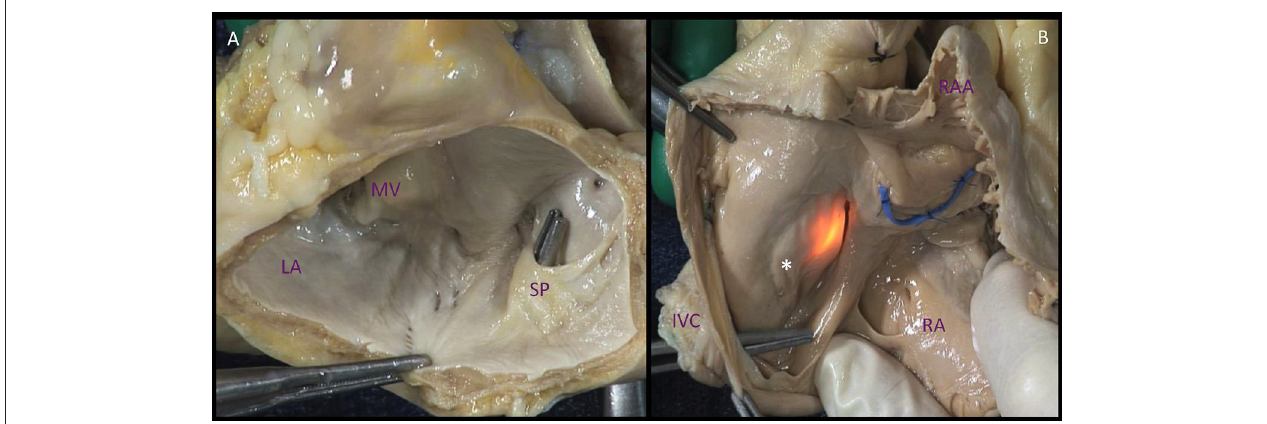
FIGURE 1 | Comparison of the atrial septal surfaces. (A) . The septal surface of the left atrium is characterized by the flap valve of the fossa ovalis (septum primum), in contrast to the limbus of the fossa ovalis (*) present on the right atrioseptal surface (B) . The source of light indicates the fossa ovalis, the blue band depicts the position of the aortic non-coronary sinus. LA, left atrium; MV, mitral valve; SP. septum primum; IVC, inferior vena cava; RA, right atrium; RAA, right atrial appendage.